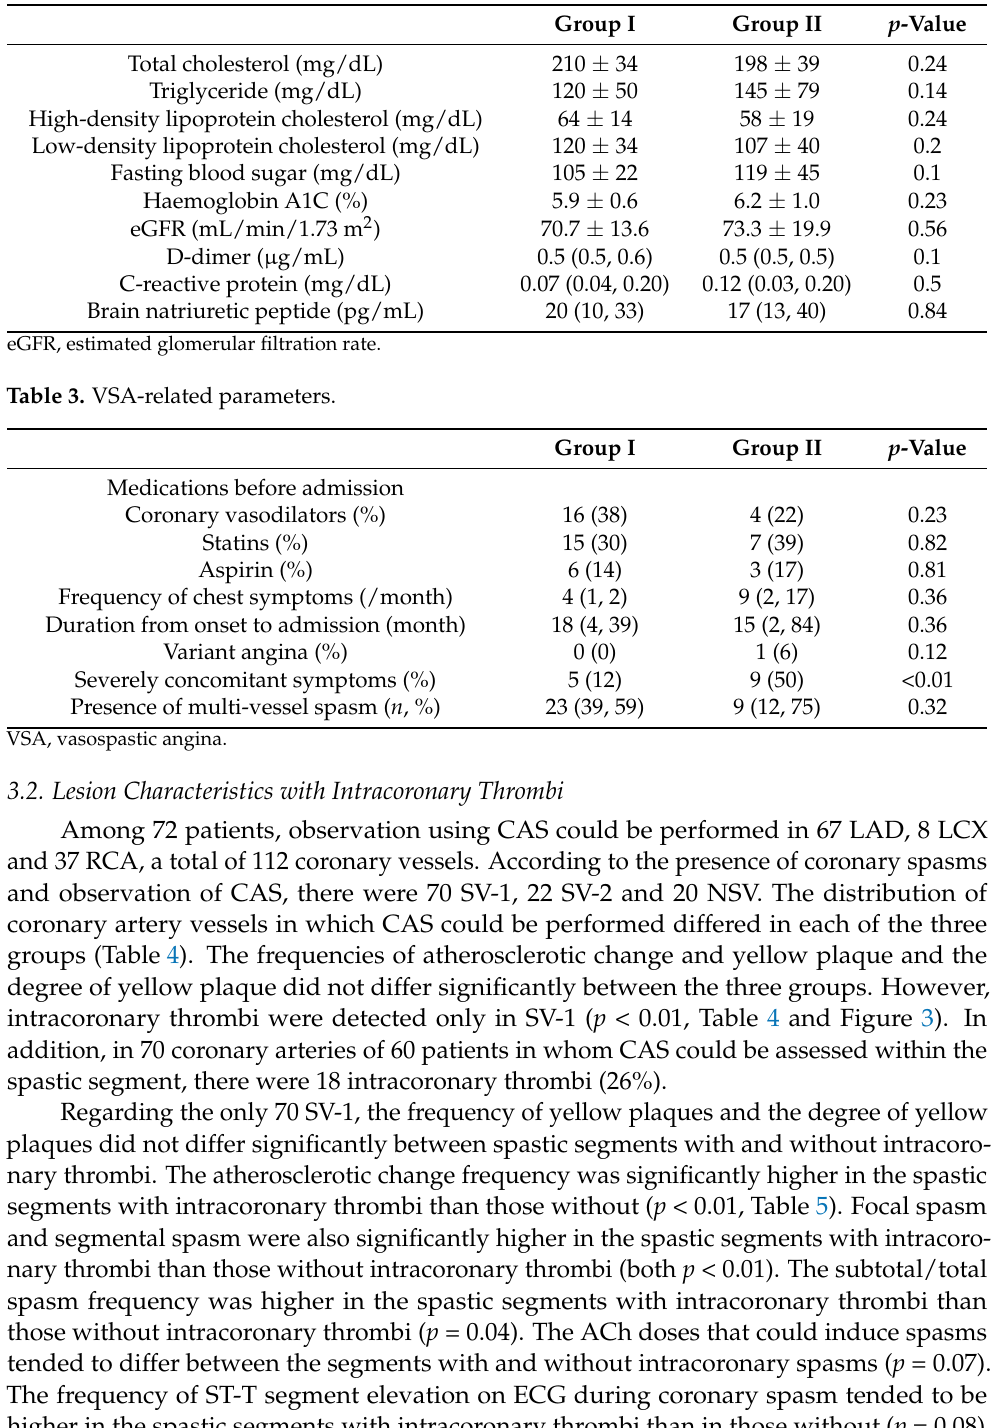
Table 2. Blood chemical parameters.